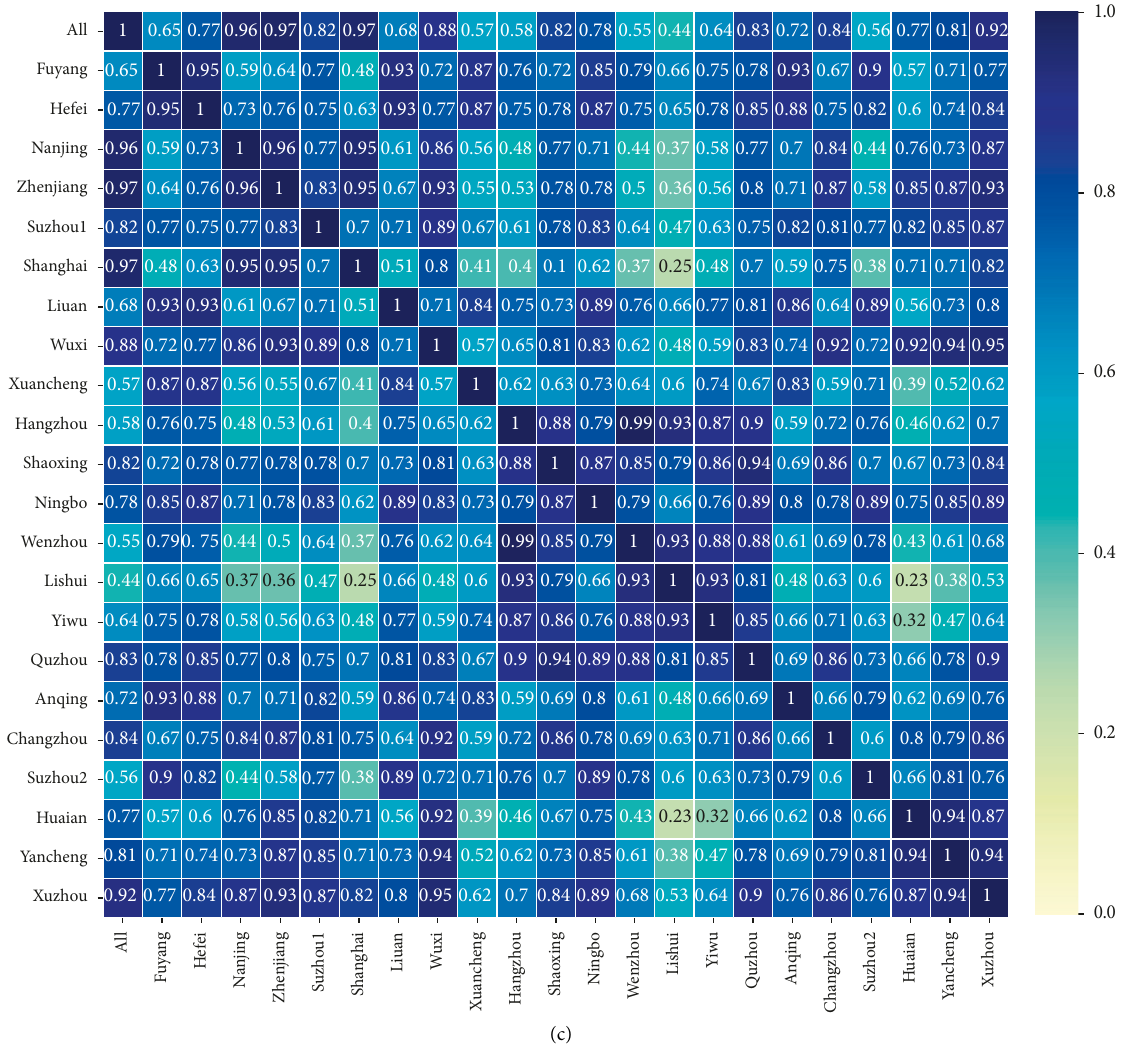
Figure 11: Matrix diagram of relevance coefficient (The data are a time series of the number of cities in the Yangtze River Delta from 1980 to 2018). (a) Correlation coefficient matrix of time series of the individual growth value. (b) Correlation coefficient matrix of time series of first- order derivative of the individual increment value. (c) Correlation coefficient matrix that weights the sum of (a) and